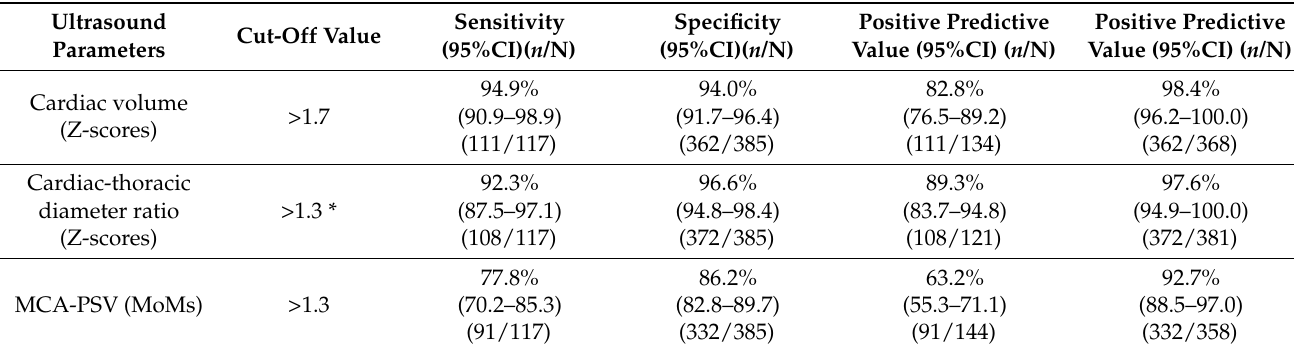
Table 3. Diagnostic indices of cardiac volume (CV), cardiac-thoracic diameter ratio (CTR) and MCA-PSV in predicting fetal Hb Bart’s